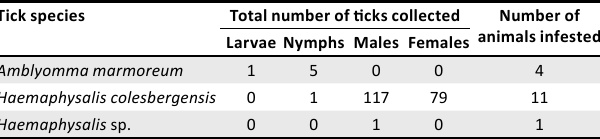
TABLE 4: Hosts and number of Haemaphysalis colesbergensis collected from carnivores near Colesberg in the eastern region of the Northern Cape Province. Host species Total number of ticks collected Number of Domestic